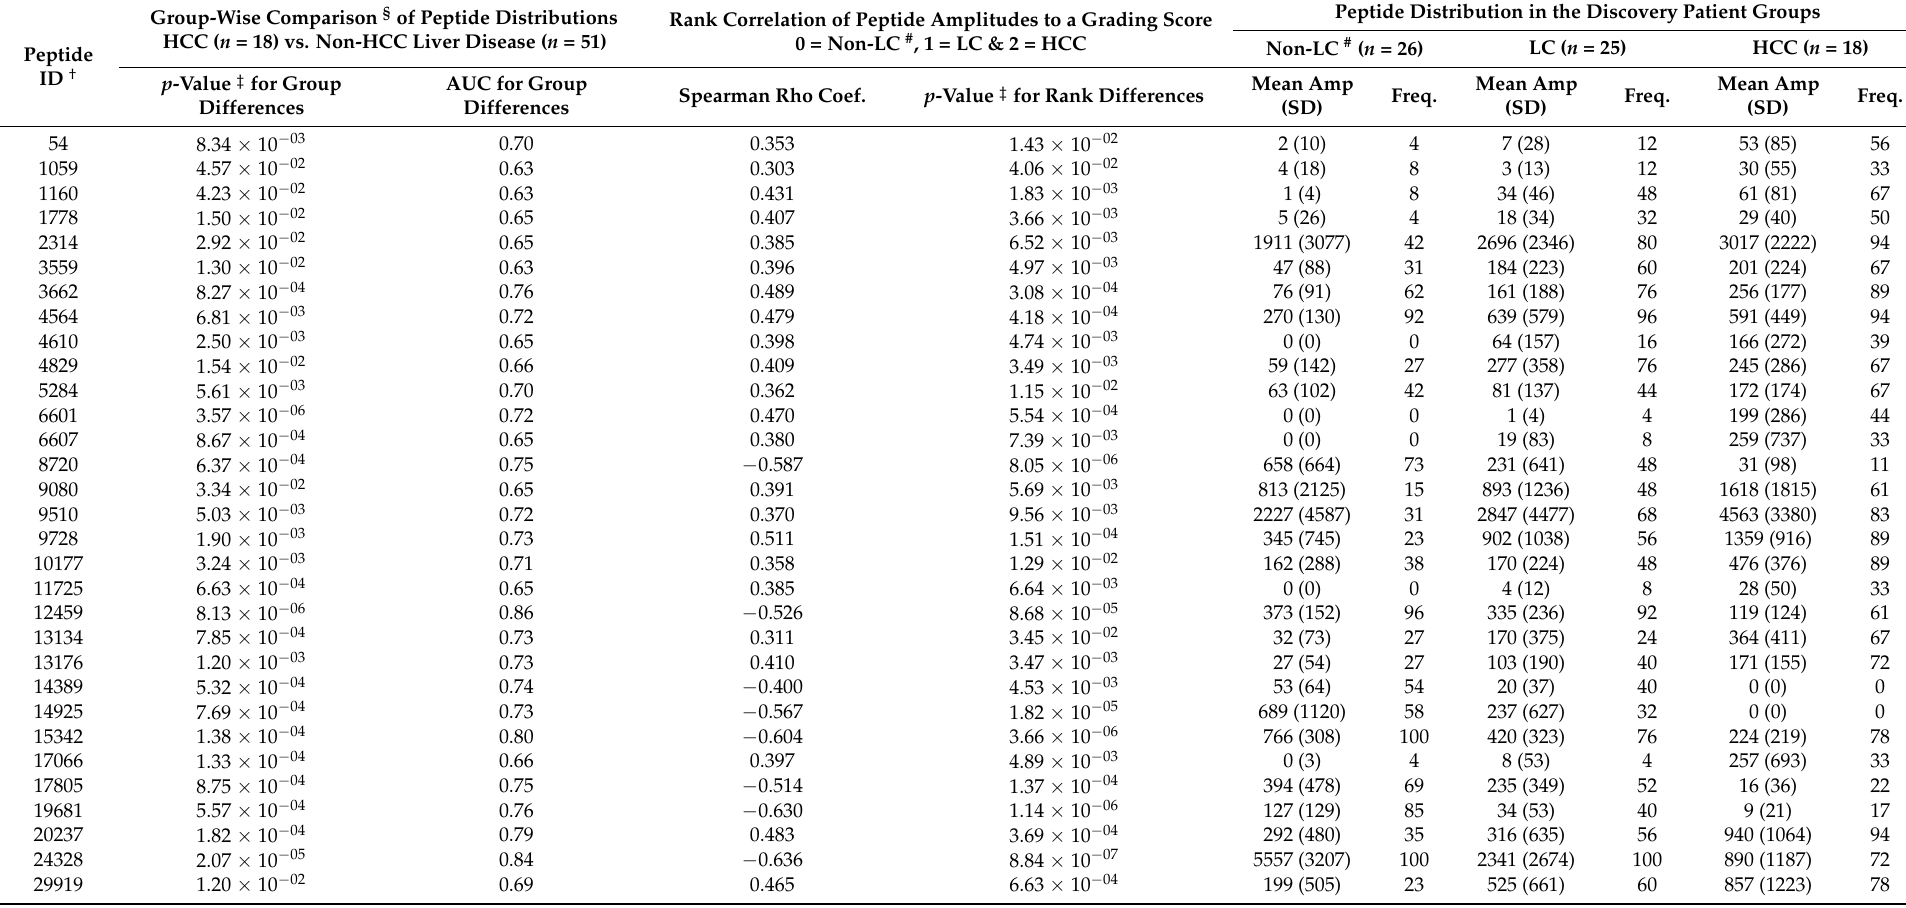
Table 2. Statistical characteristics and peptide marker distributions in the HCC case and non-HCC liver disease control discovery groups of the 31 urinary peptides included in the HCC peptide marker